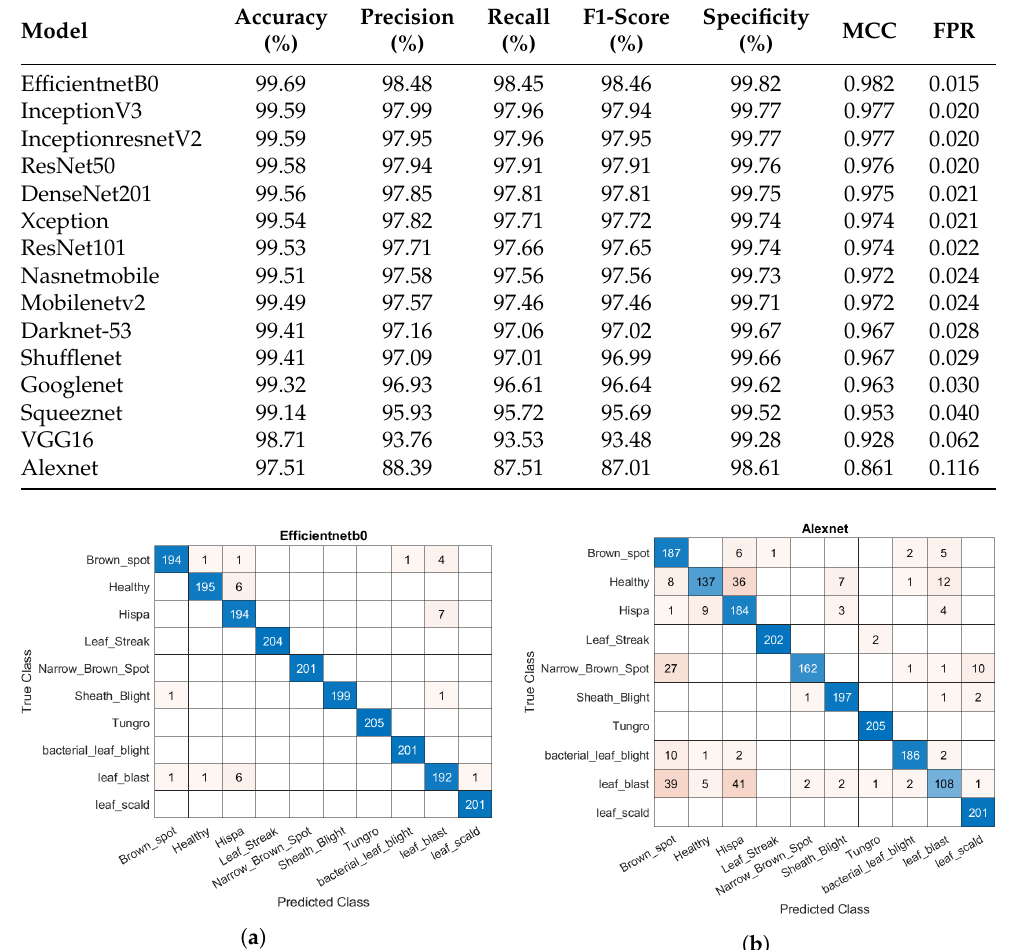
Figure 5. Confusion matrices for the finest and the poor performing pre-tarained models using 80% of the training data. ( a ) EfficientNetb0; ( b )